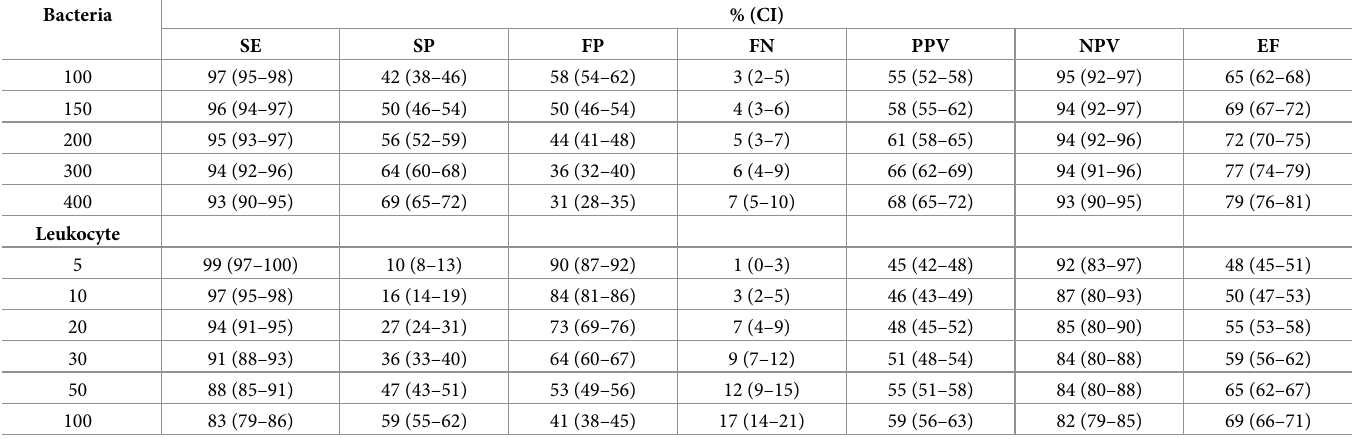
SE: Sensitivity; SP: Specificity; FP: False positive; FN: False negative, PPV: Positive Predictive Value; NPV: Negative Predictive Value, EF: Effectiveness; CI: Confidence Interval